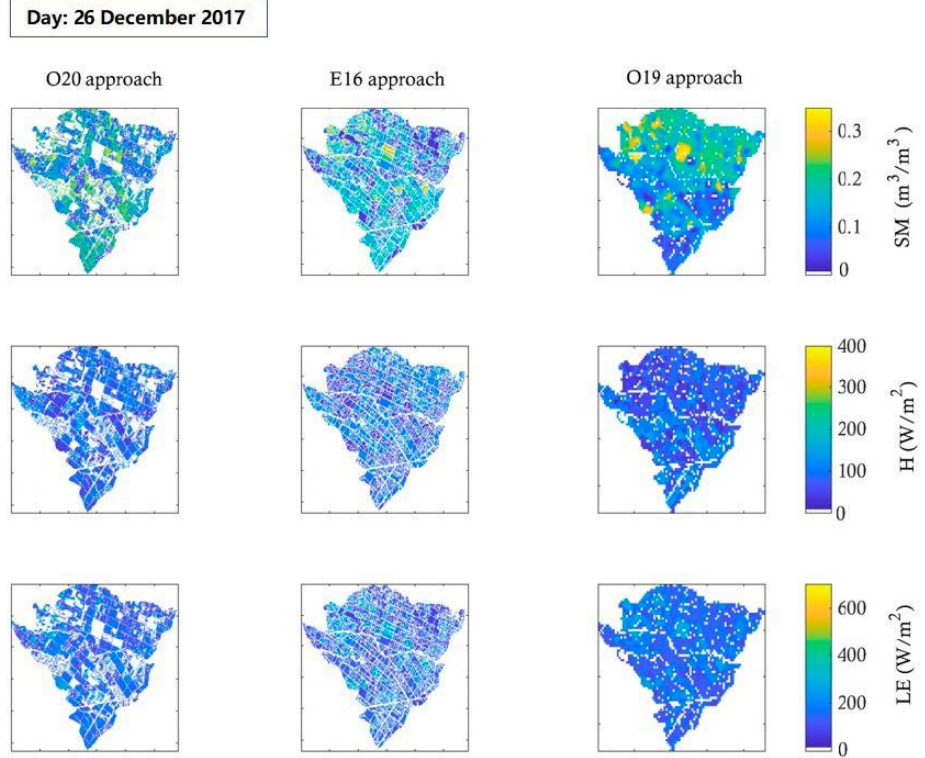
Figure 9. SM, H, and LE maps over an irrigated perimeter located 40 km east of Marrakech named R3 using three different input SM datasets (26 December 2017).